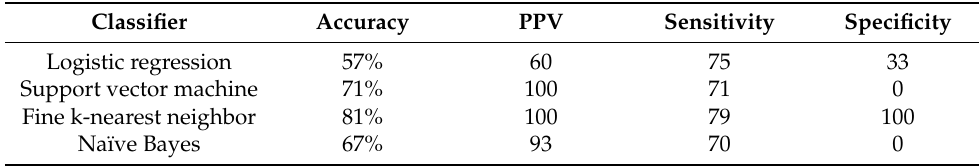
Table 2. Classifiers’ comparison based on 3-fold